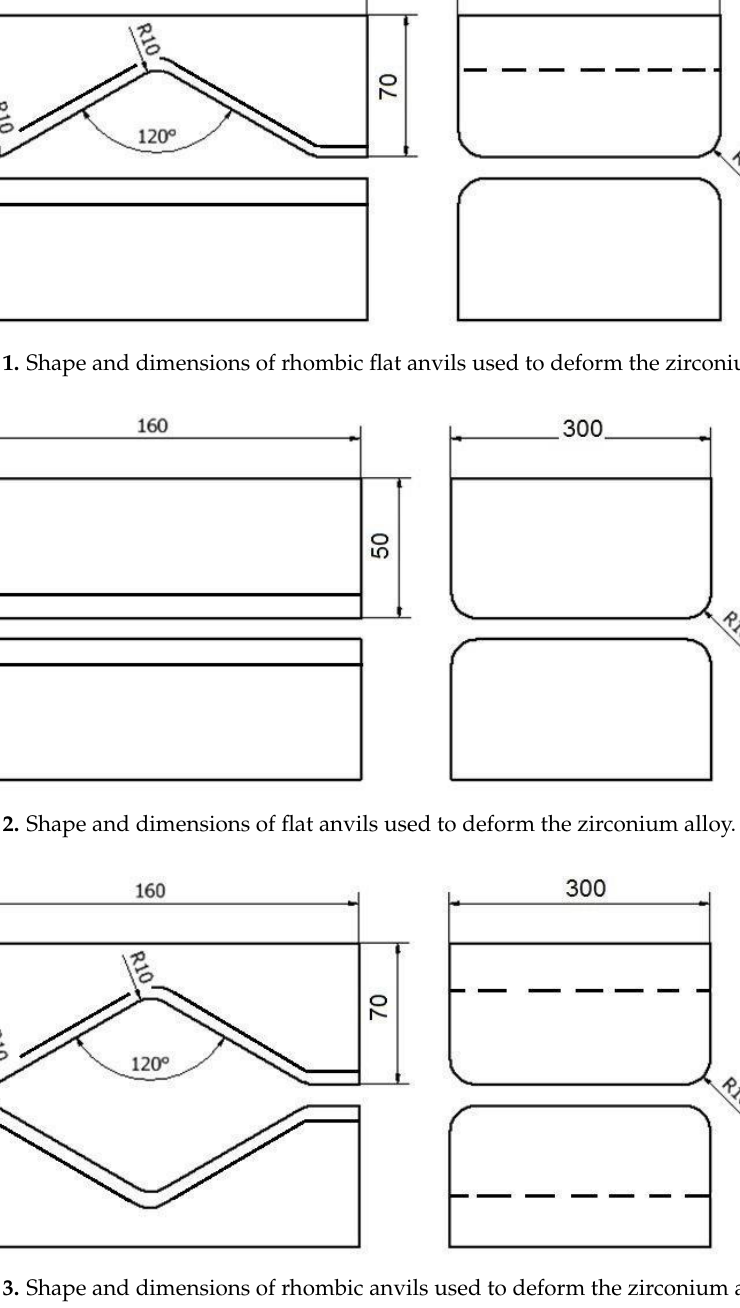
Figure 3. Shape and dimensions of rhombic anvils used to deform the zirconium alloy.